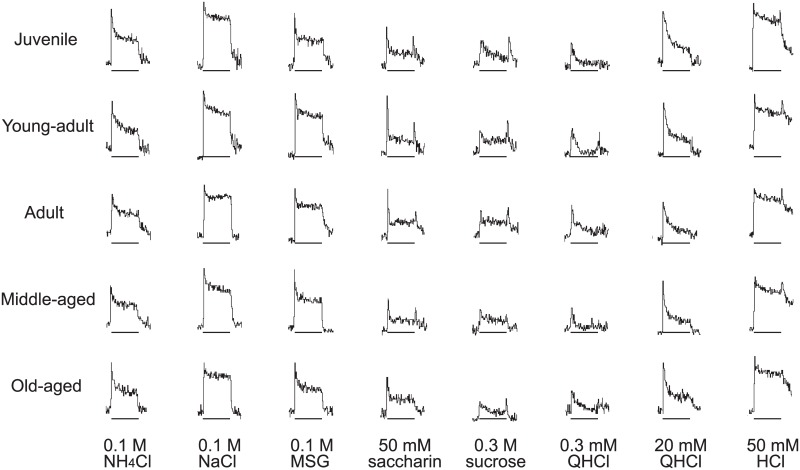
A representative integrated response of the chorda tympani nerve to 0.1 M NH4Cl, 0.1 M NaCl, 0.1 M MSG, 50 mM saccharin, 0.3 M sucrose, 0.3 mM QHCl, 20 mM QHCl, and 50 mM HCl for each age group.The horizontal bar indicates a stimulus duration of 30 s.